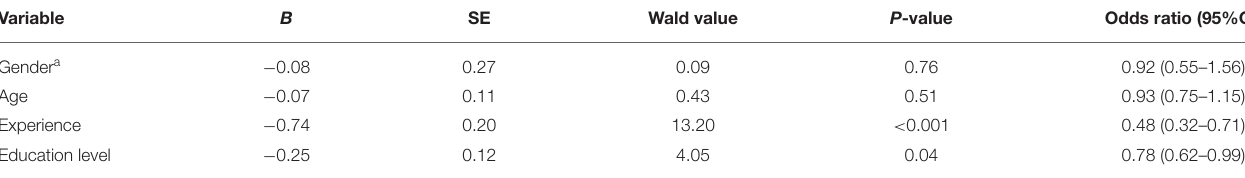
TABLE 5 | The relationship between demographic characteristics and behavior intention to use telemedicine.